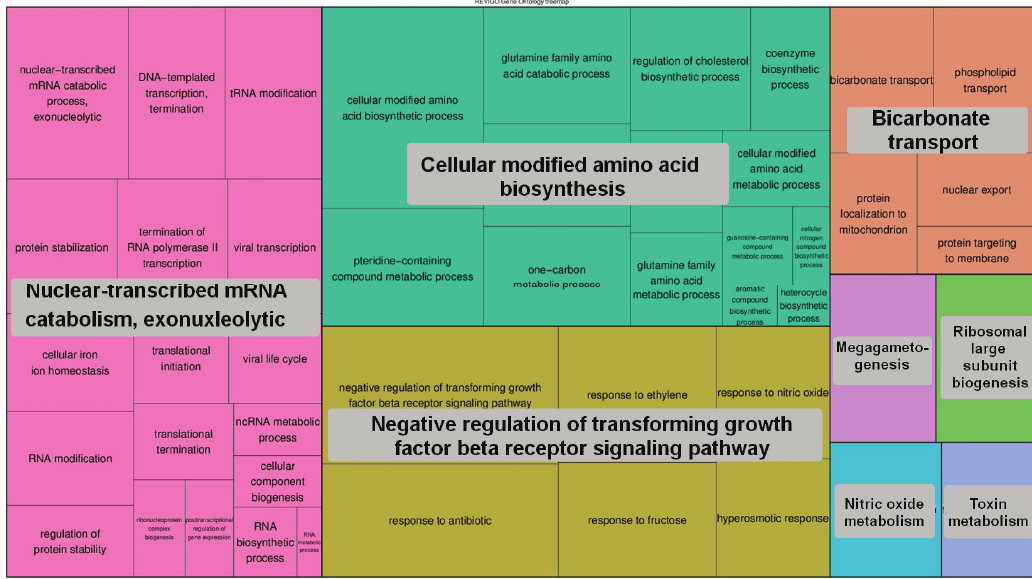
Figure 6. The GO terms (biological process) that were enriched for genes void of 5-hmC. The areas of rectangles are proportional to the relative increase in frequency of GO terms comparing genes that completely lacked 5-hmC-related peaks to genes that had them. The corresponding quantitative data and a full list of GO terms can be found in Supplementary File S2.